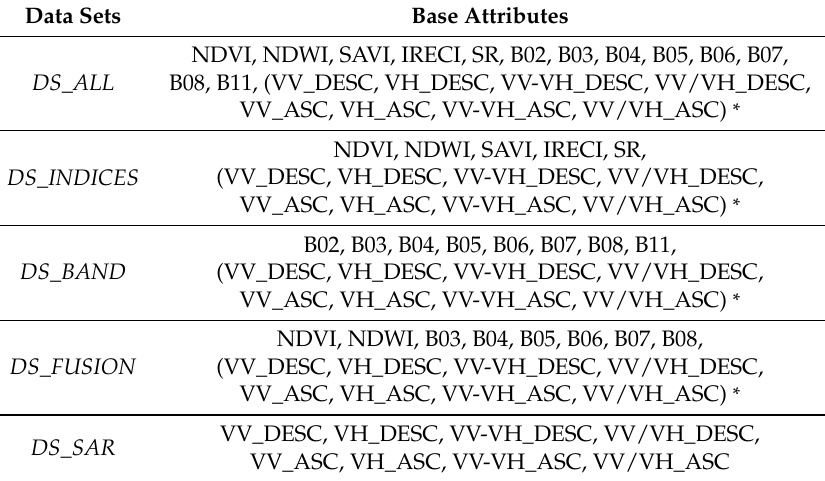
Table 2. Tested data sets and its